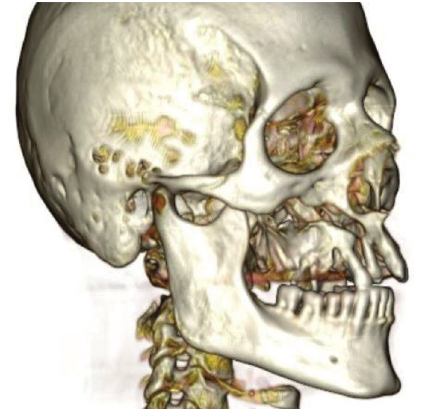
Figure 2: Three-dimensional reconstruction of CT scans that highlighted the detachment of the right hemimaxilla.